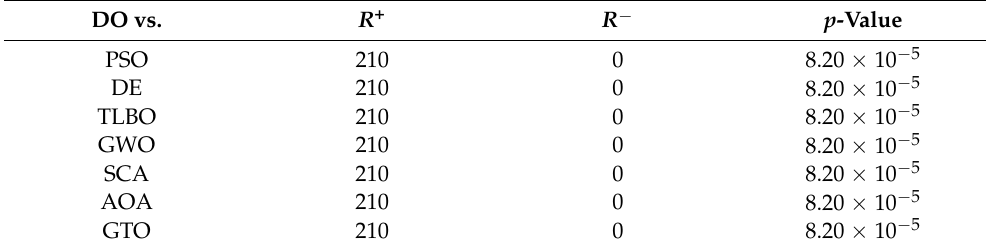
Table 7. Wilcoxon signed-rank test for the pairwise comparison between DO and other nature- inspired algorithms when optimizing the delamination size at the bottom side. DO